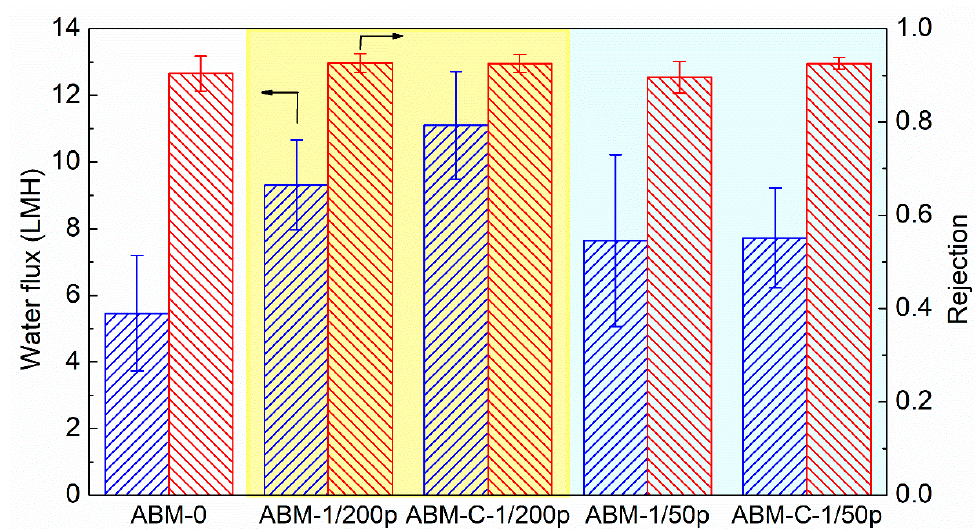
Figure 5. Impacts of the addition of cholesterol in proteoliposomes on the water flux and rejection of the ABM. The molar ratio of cholesterol in the proteoliposome was 30%. The concentration of proteoliposome in the MPD solution was 0.016 wt/wt% for all AqpZ-containing membranes. All tests were performed at 5 bar, with 10 mM NaCl solution as a feed solution. The error bars were derived from results tested with 3 independent membrane samples.